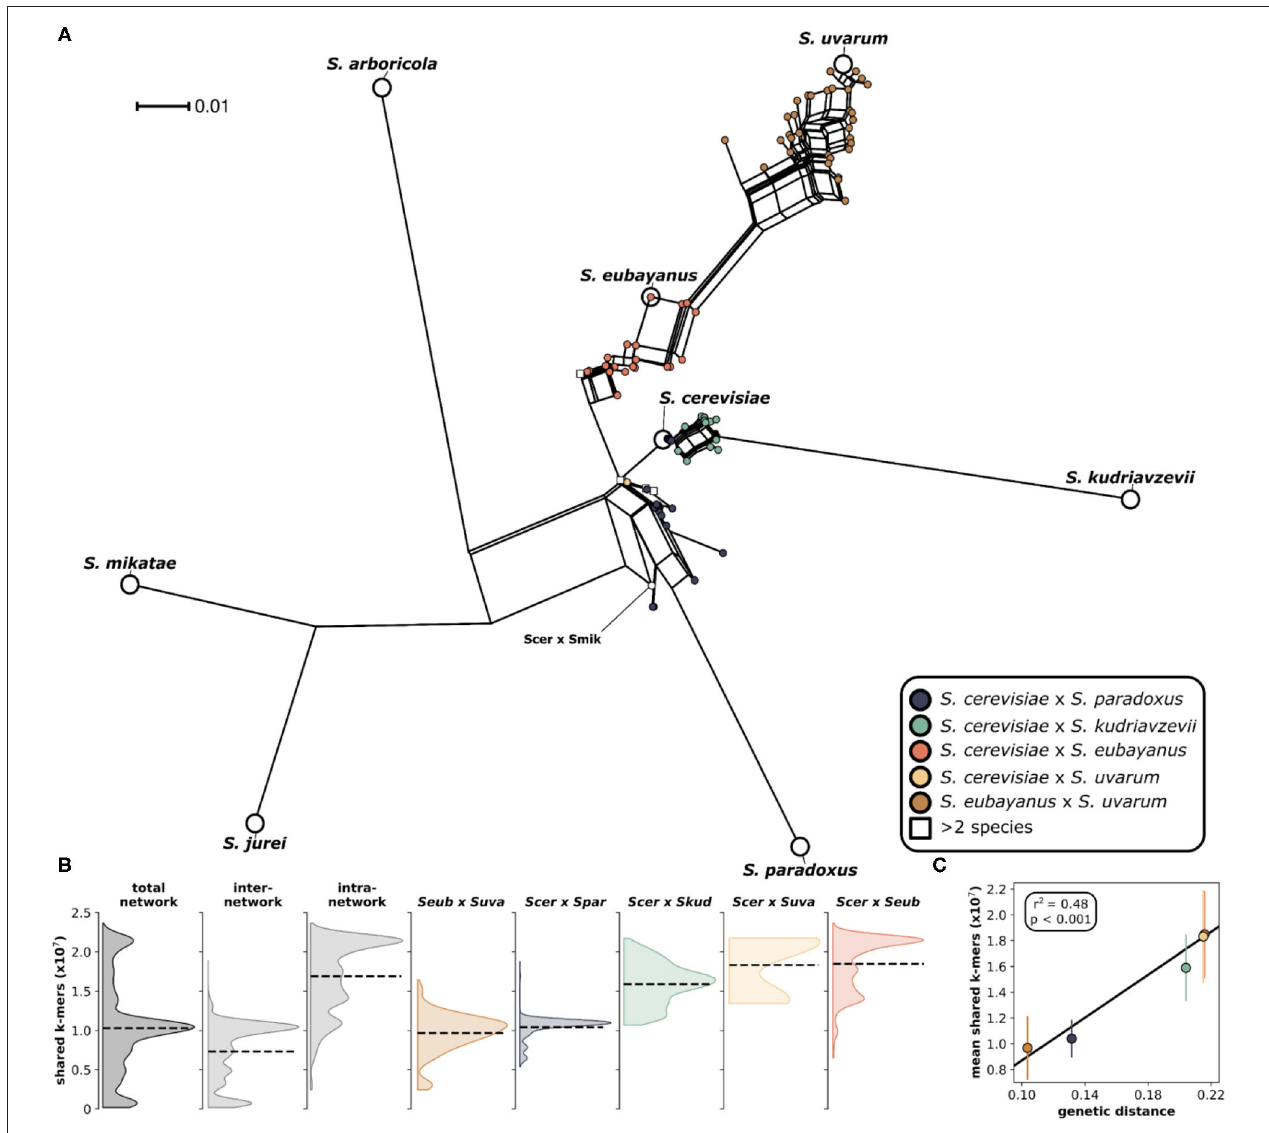
FIGURE 2 | Phylogenetic network of Saccharomyces interspecific hybrids. (A) A neighbor net splits tree based on the distance matrix generated from a k-mer analysis using an assembly and alignment free approach (AAF). The analysis was performed on the trimmed sequencing reads with k-mer size of 17 and a threshold frequency of 5 for each k-mer to be retained in the analysis. Pure species are indicated with larger white circles and are labeled. Each circle indicates a hybrid and is colored according to the legend. Hybrids with more than two parents are indicated with a square. The single S. cerevisiae × S. mikatae hybrid is labeled (Scer × Smik). (B) Distributions of shared k-mers for each hybrid cross. Total network includes all pairwise k-mer comparisons both within and between hybrid crosses. Inter-network includes only k-mer comparisons between hybrid crosses. Intra-network includes all k-mer comparisons within each hybrid cross. Distributions for individual hybrid crosses include only k-mer comparisons with other genomes within the same hybrid cross. Dashed lines indicate the distribution mean. (C) Correlation between mean shared k-mers and genetic distance between the two parental species. Vertical lines indicate the standard deviation of the